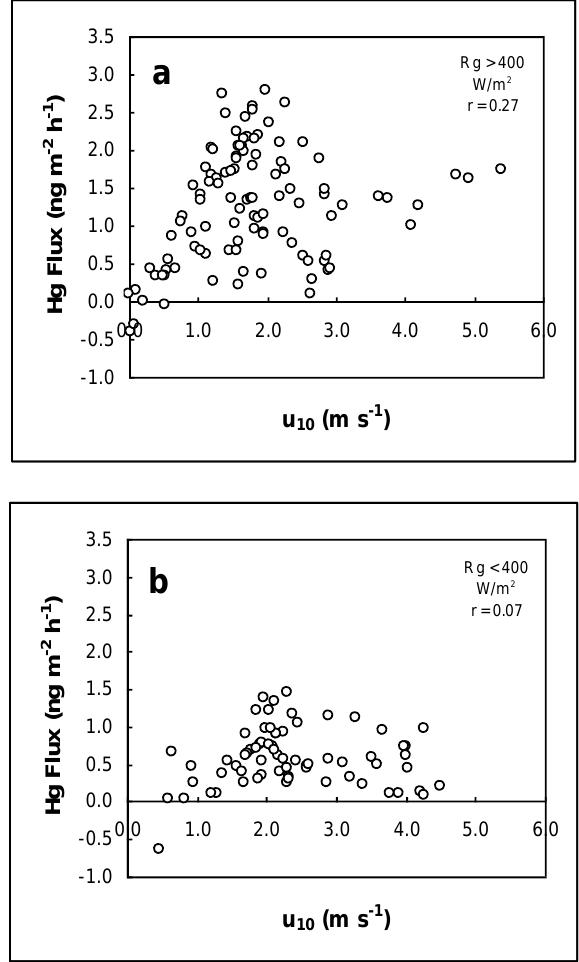
Figure 8. The correlation between Hg air / water exchange flux and wind speed ( u 10 ) for all the data with the daily mean solar radiation ( R g ) ( a ) > 400 W m − 2 ( r = 0.27) and ( b ) < 400 W m − 2 ( r = 0.07).